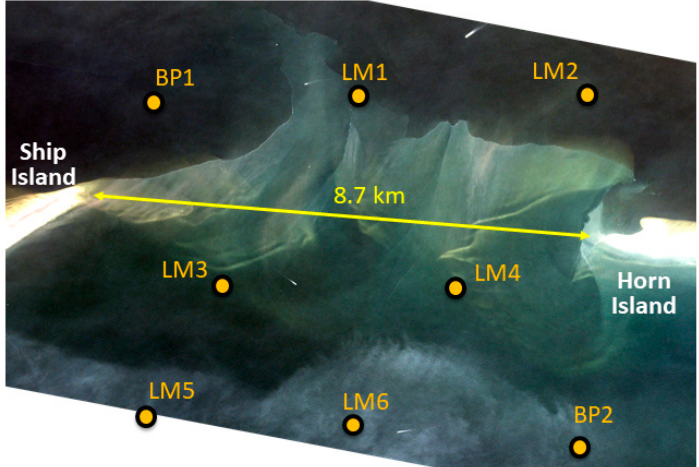
Figure 3. Mooring locations in Mississippi Sound, between Ship and Horn Islands. The background is a true color Planet nanosatellite image collected at 1600 UTC on 3/25/2018.